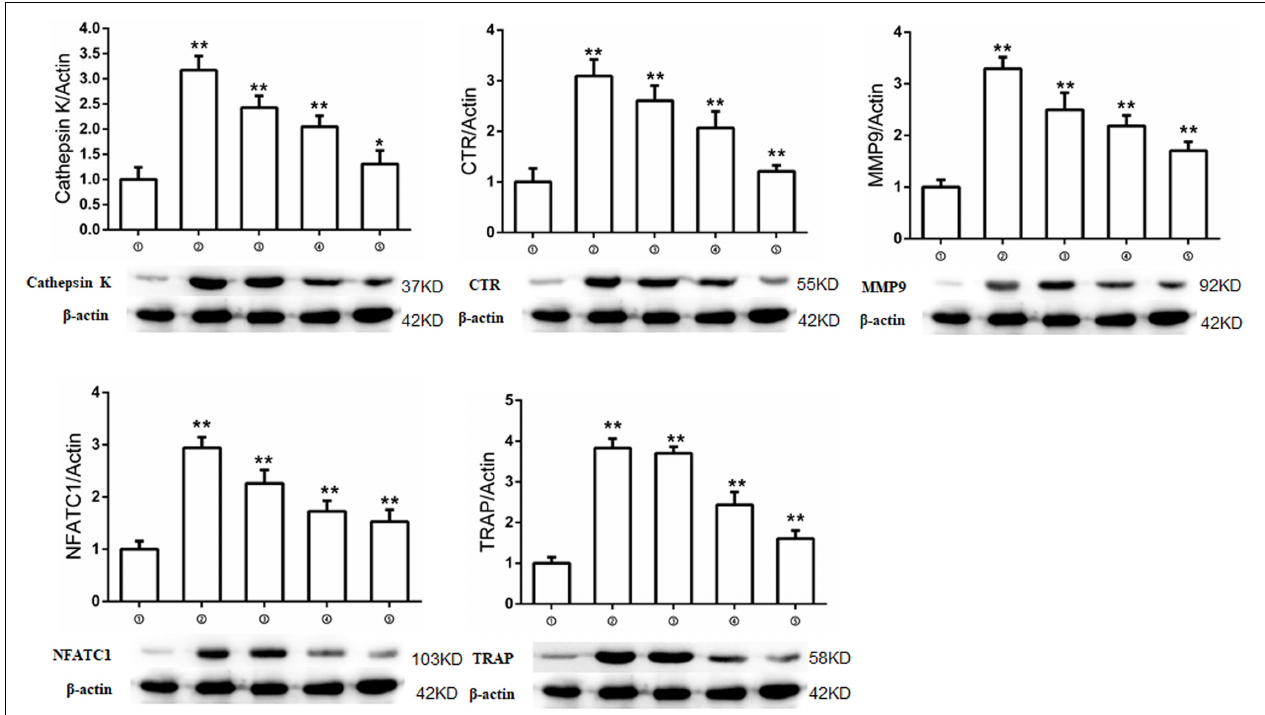
FIGURE 3 | M54 inhibits expressions of osteoclastogenesis-related markers. Western blot and optical density analysis of expression of Cathepsin K, CTR, MMP-9, NFATc1, and TRAP with Beta actin as reference. (cid:172) RAW264.7 cells; (cid:173) RAW264.7 cells induced with M-CSF, RANKL and PBS; (cid:174) RAW264.7 cells induced with M-CSF, RANKL and treated with 1 µ M M54; (cid:175) RAW264.7 cells induced with M-CSF, RANKL and treated with 2 µ M M54; (cid:176) RAW264.7 cells induced with M-CSF, RANKL and treated with 4 µ M M54. The membranes were cut according to the molecular size of the target protein and reincubated with primary antibodies but using the same loading control ( ∗∗ P < 0.01, ∗ P < 0.05 vs. (cid:173)